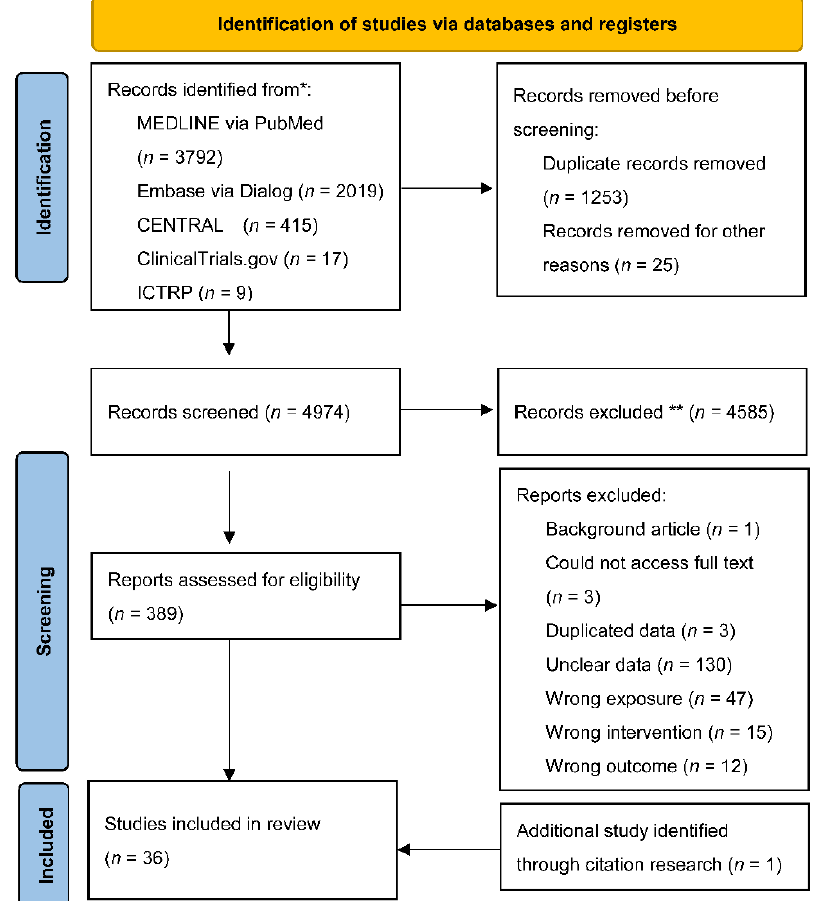
Figure 1. Preferred reporting items for systematic reviews and meta-analysis (PRISMA) flowchart.